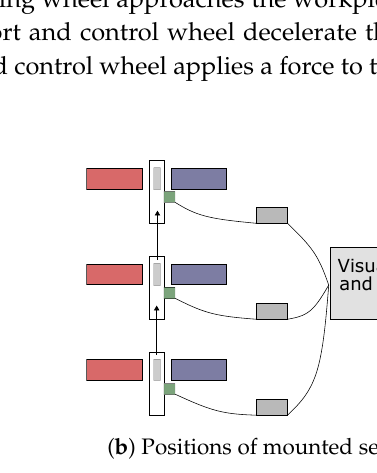
Figure 3. ( a ) Basic parts of a centerless external grinding machine. ( b ) Positions of mounted sensors at the grinding machine in our study. Three separate grinding/control wheel pairs allow for efficient machining of complex workpieces with successive processing